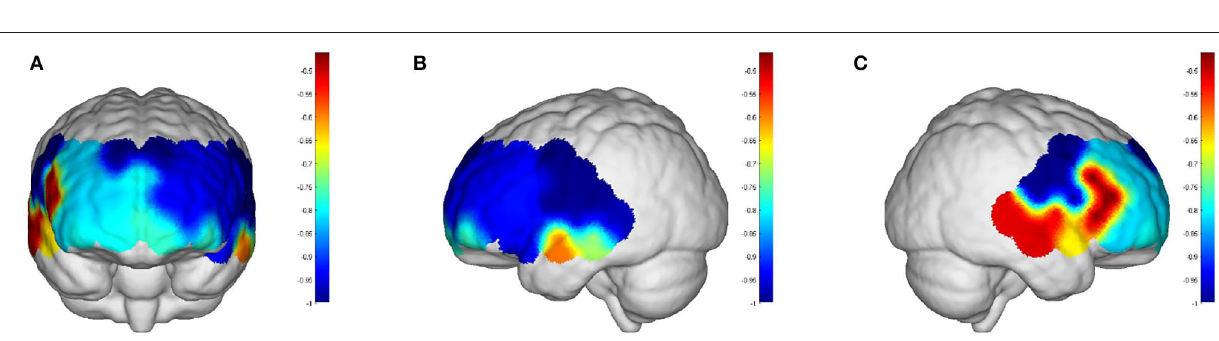
FIGURE 5 | The p- values of the comparison between task values and rest values for older adults: (A) front view; (B) left view; (C) right view. But both the prefrontal and DLPFC showed a strong activation and were statistically significant ( p < 0.05).